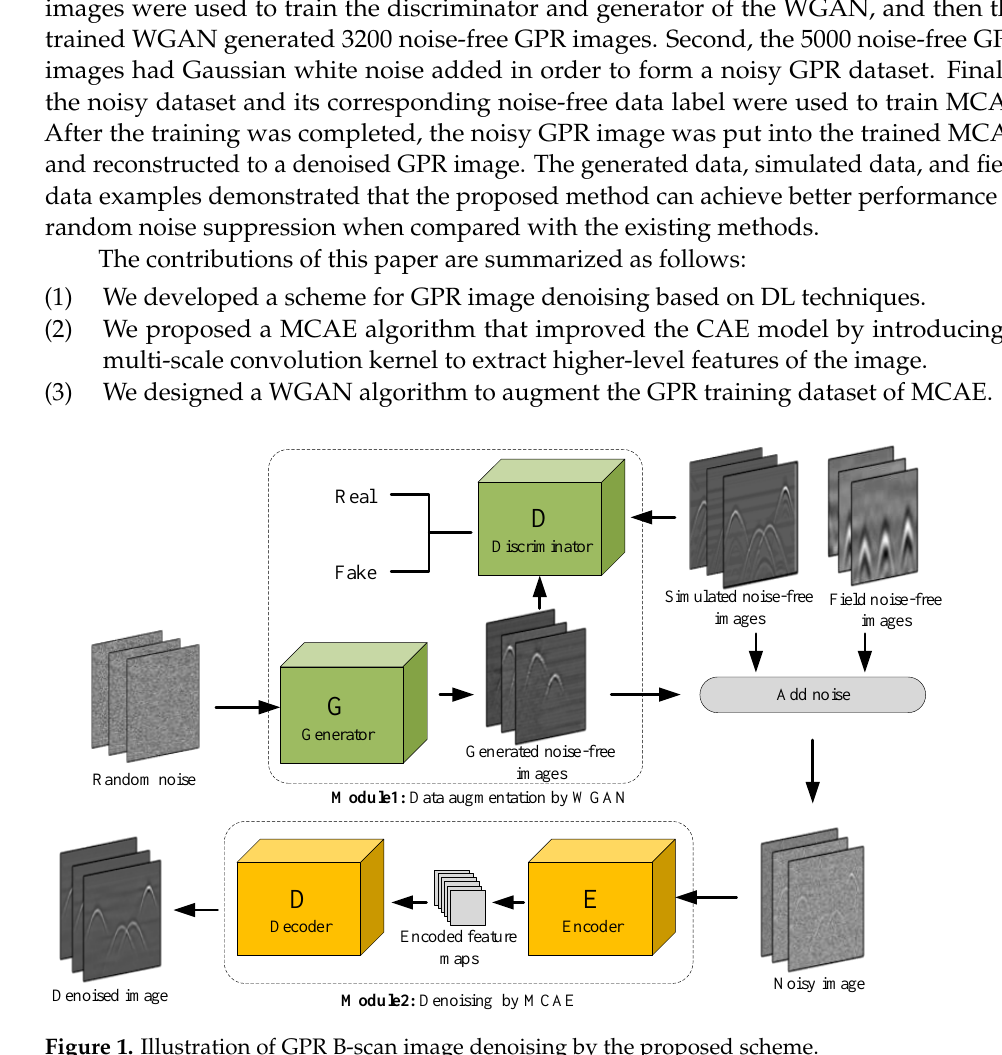
Figure 1. Illustration of GPR B-scan image denoising by the proposed scheme.